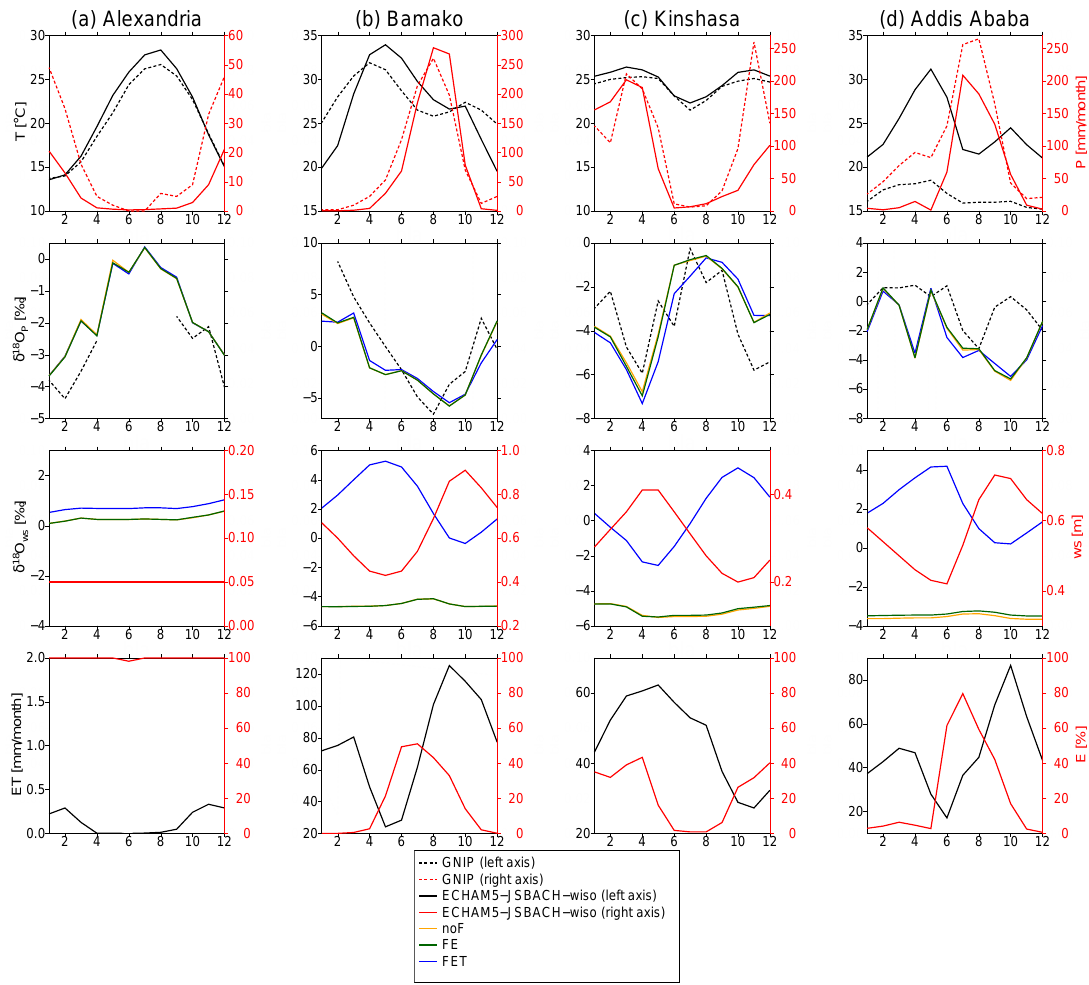
Fig. 12. As Fig. 10 but for the locations (a) Alexandria, (b) Bamako, (c) Kinshasa, and (d) Addis Fig. 12. As figure 10, but for the locations (a) Alexandria, (b) Bamako, (c) Kinshasa, and (d) Addis Ababa.